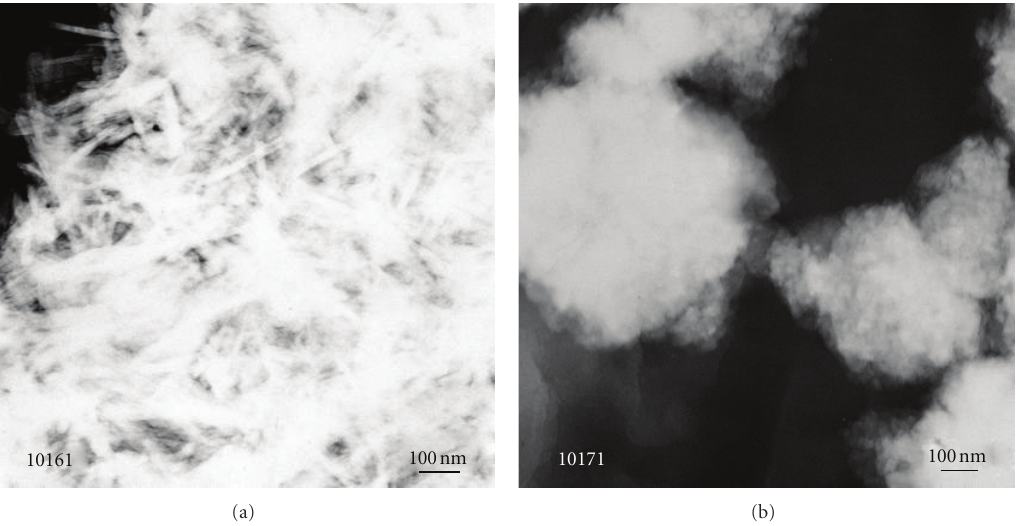
Figure 4: Hydroxyapatite powder after one hour of milling with W p : W b = 1 : 40.